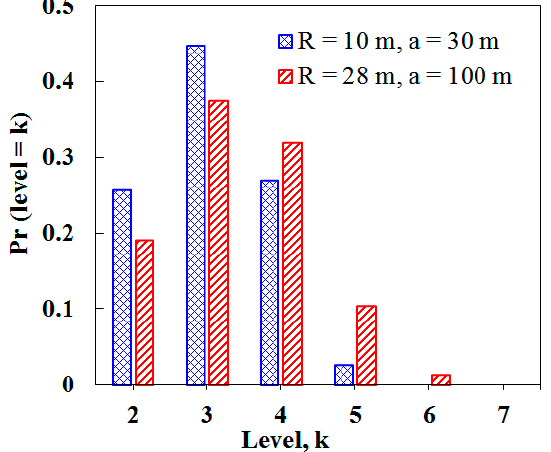
Figure 7. The maximum number of competing nodes at any tree level.